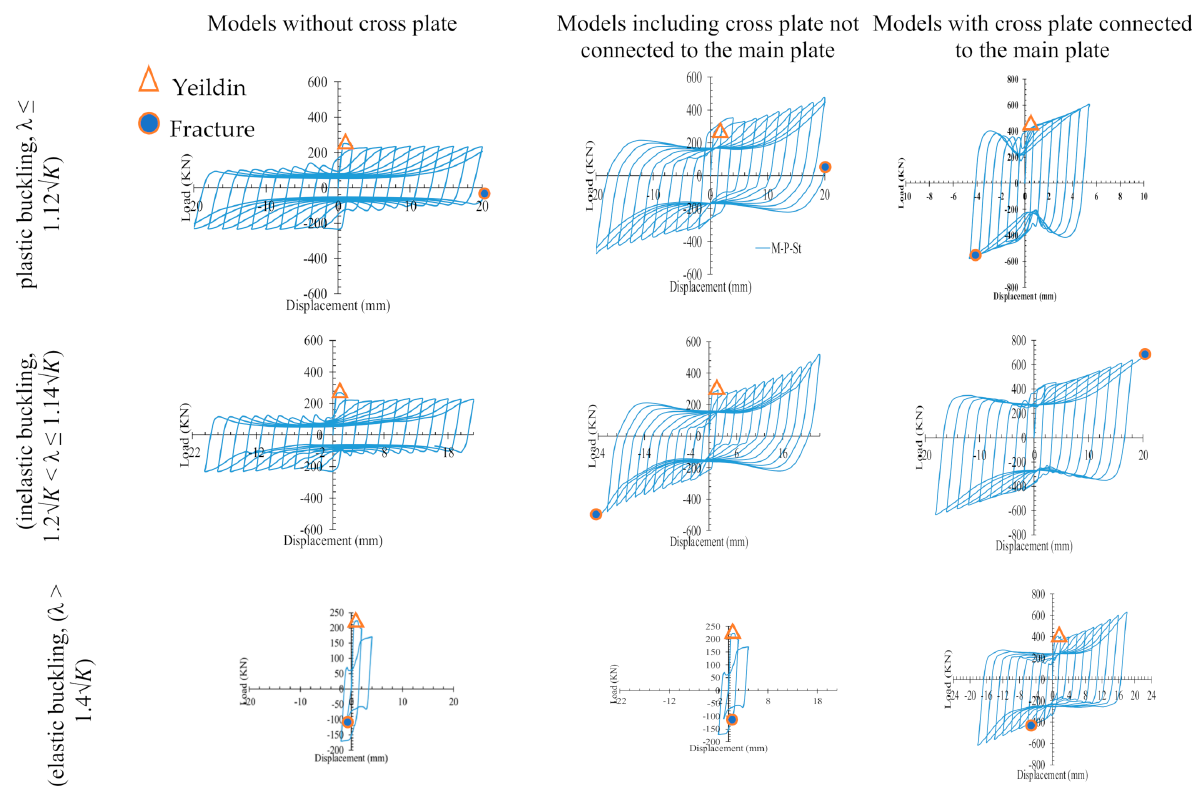
Figure 13. Hysteresis curves of FE models.